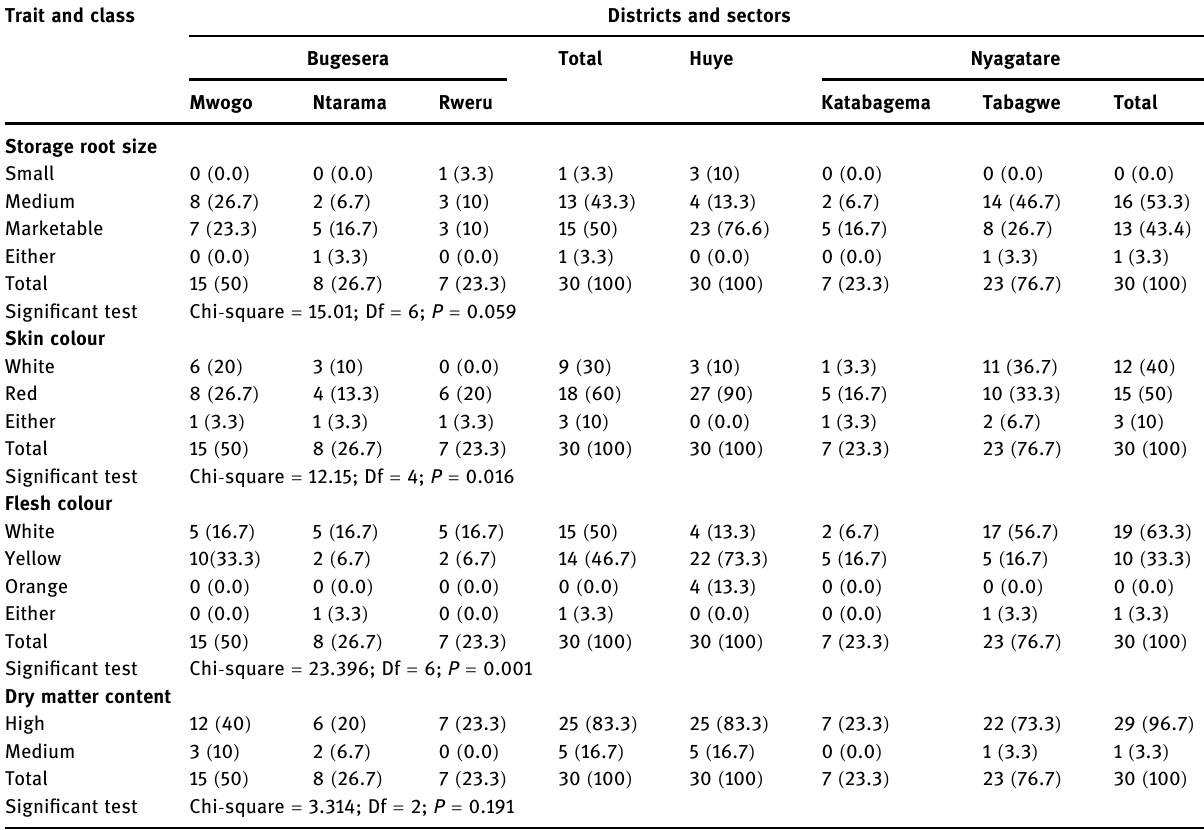
Table 6: Farmer - preferred traits of sweetpotato roots in Bugesera, Huye, and Nyagatare Districts of Rwanda Trait and